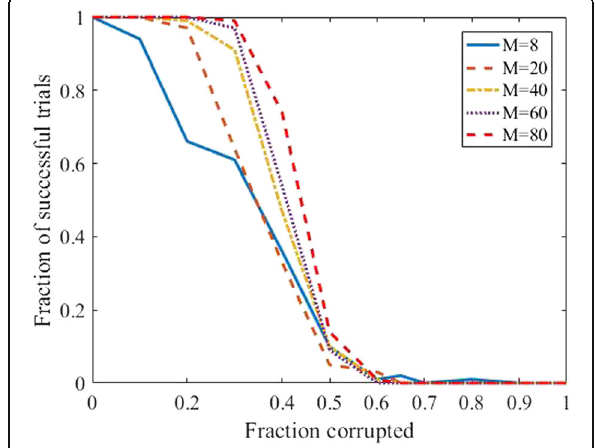
Fig. 5 Error correction in L1 optimization when m ∈ {8, 20, 40, 60, 80} and ‖ x 0 ‖ = m 1/2 . Legend ( ‘ M = 8 ’ , ‘ M = 20 ’ , ‘ M = 40 ’ , ‘ M = 60 ’ , ‘ M = 80 ’ )